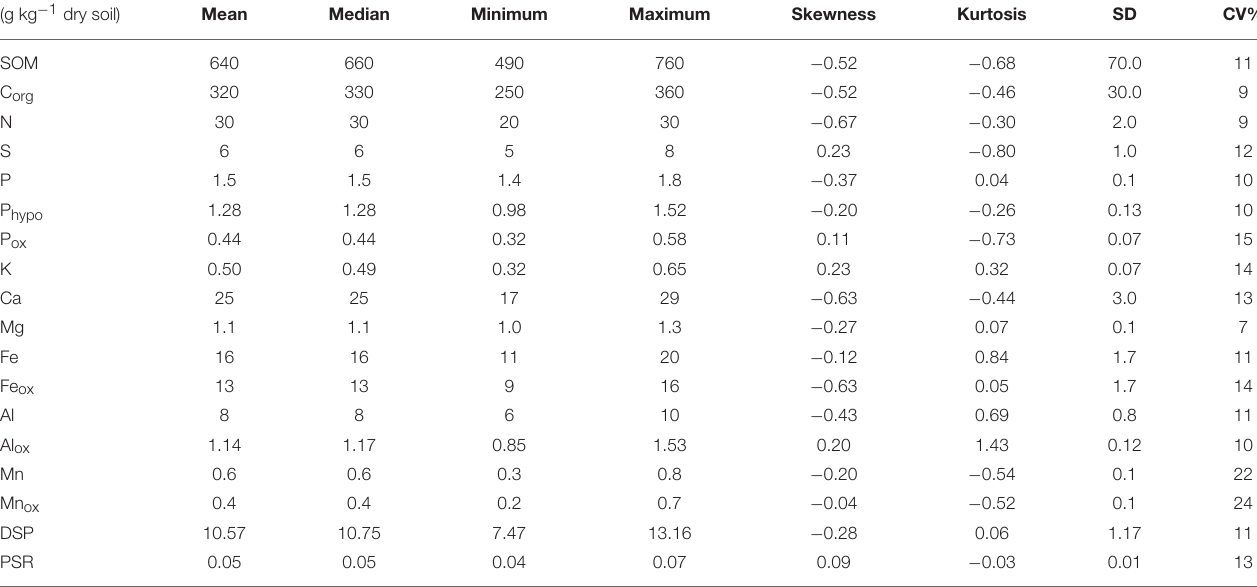
TABLE 3 | Soil organic matter, total, and ammonium oxalate extractable elements concentrations in the surface soil of a rewetted peatland. (g kg − 1 dry